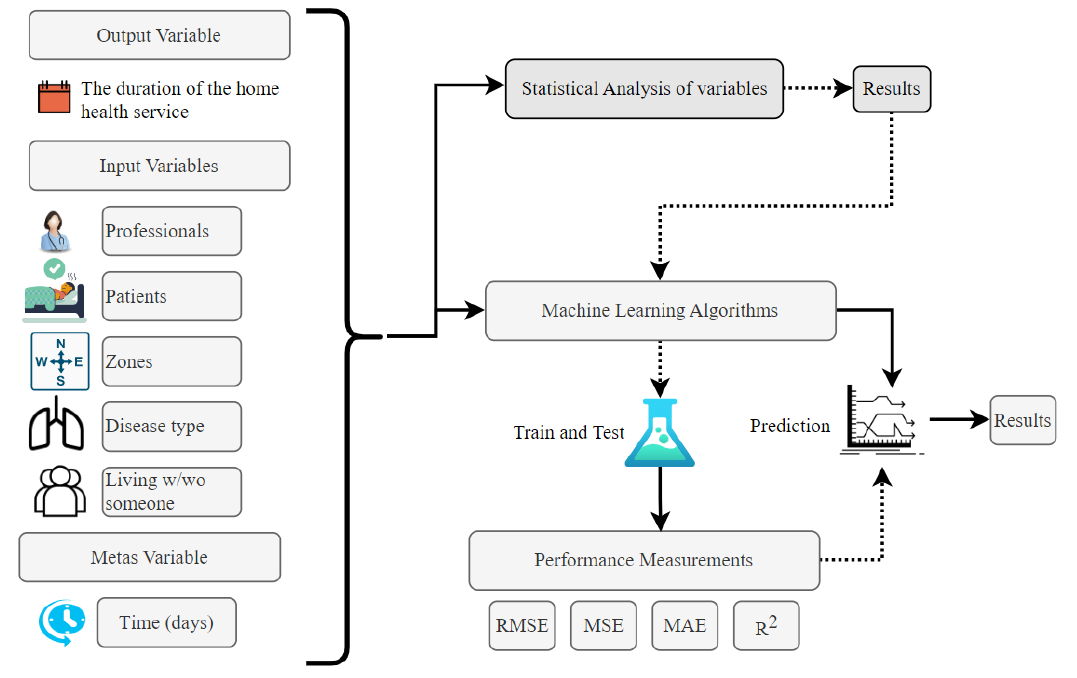
Figure 2. The flowchart of the method proposed.